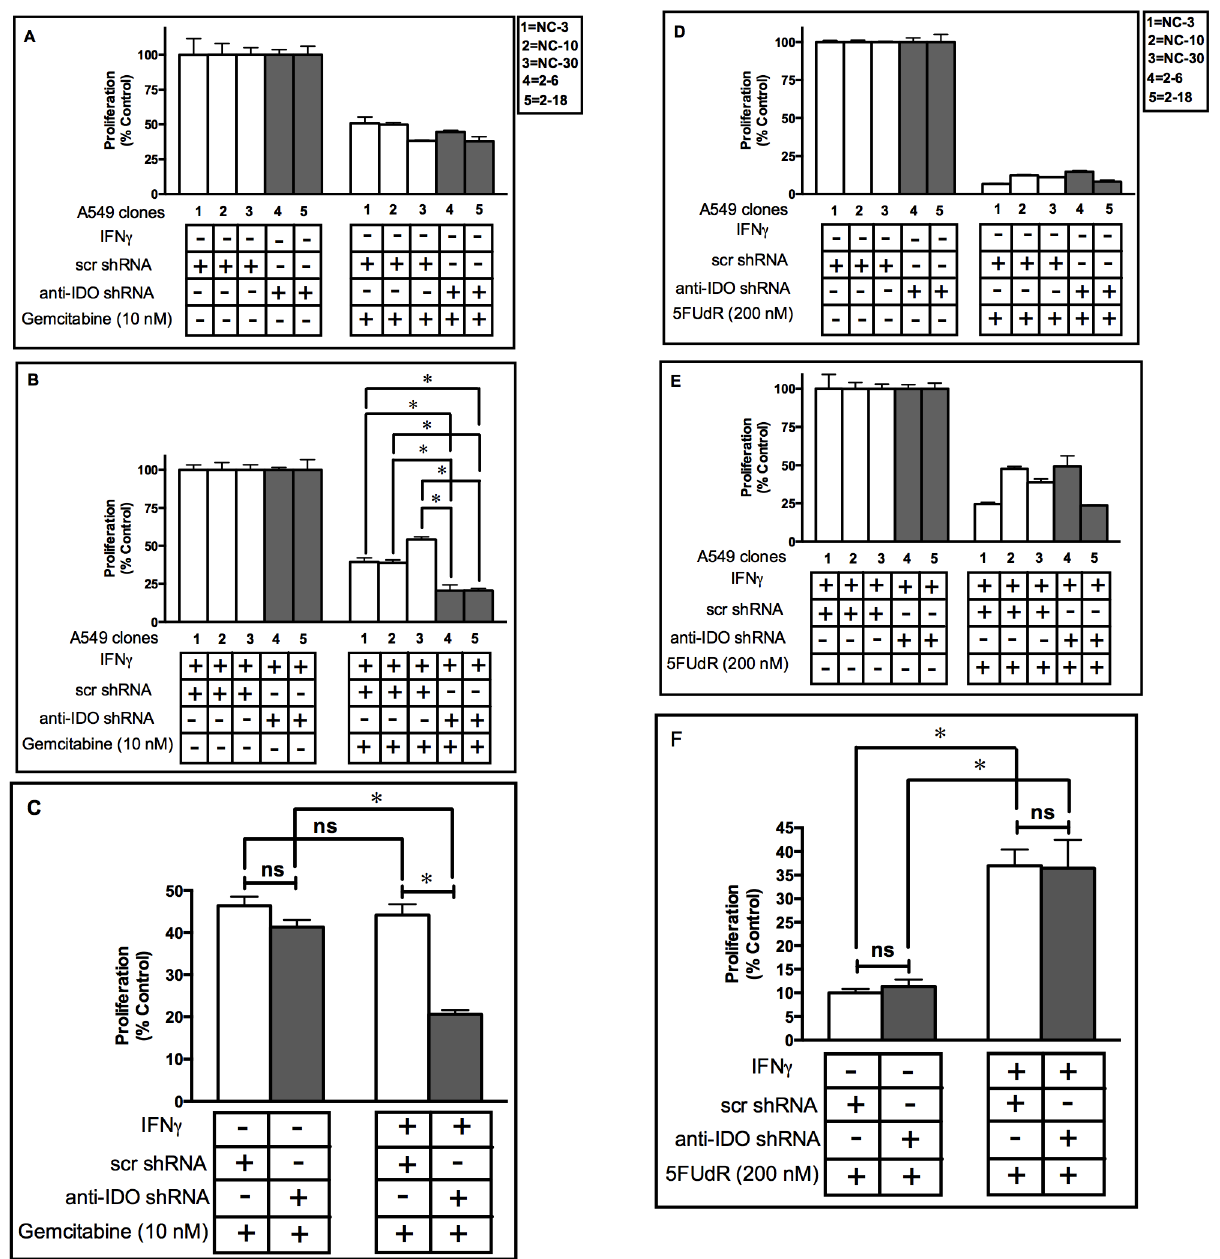
Fig 5. A549 clone sensitivity to Gemcitabine and 5FUdR before and after IDO induction. Proliferation of each of 5 individual A549 cell clonal populations before (Panel A and C) and after (Panel B and C) IDO induction with IFN γ . A549 clonal populations were cultured with or without IFN γ (25 ng/ ml) for 48 h, treated with gemcitabine (10 nM) for 72 h, and then enumerated. White bars : A549 clones transfected with scrambled, non-targeting control shRNA. Gray bars : A549 cells transfected with anti-IDO shRNA. Each bar represents a mean of 9 (white bars) or 6 (black bars) values ± SD for Panels A and B and SEM for panel C, ( * p < 0.05). Results are normalized to control cells not treated with Gemcitabine, without (panel A) or with (panel B) IFN γ treatment. Panels D-F : Proliferation of each of 5 individual A549 cell clonal populations before and after IDO induction with IFN γ . A549 clonal populations were cultured with or without IFN γ (25 ng/ml) for 48 h and, 5FUdR (200 nM) for 72 h, and then enumerated. White bars : A549 clones transfected with scrambled, non- targeting control shRNA. Gray bars : A549 cells transfected with anti-IDO shRNA. Each bar represents a mean of 9 (white bars) or 6 (black bars) values ± SD for Panels D and E and SEM for panel F ± SD. * Significant difference, Student's t -test, p < 0.05. Results are normalized to control cells not treated with 5FUdR, without (panel A) or with (panel B) IFN γ